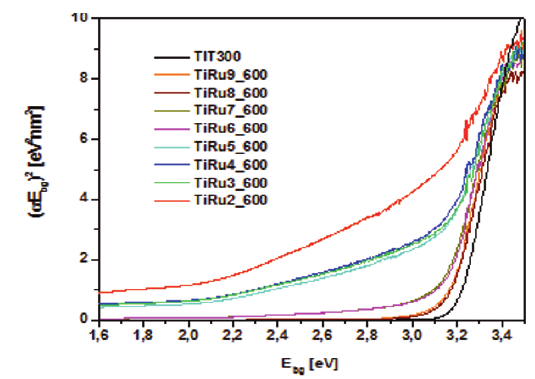
Figure 8. Band-gap energy of Ru-doped titania samples and undoped titania (TIT